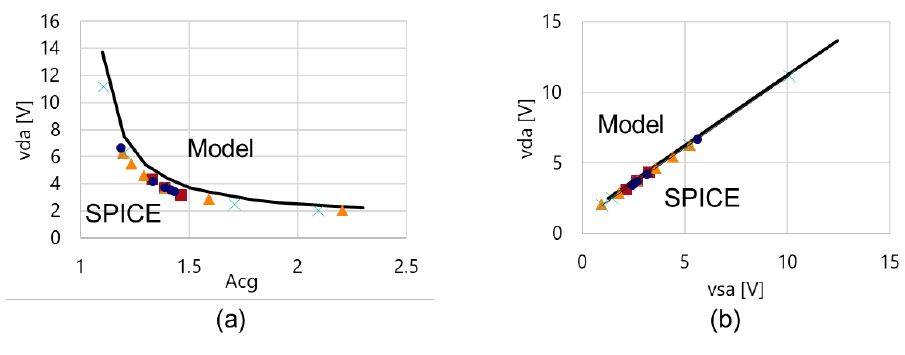
Figure 11. ( a ) A CG vs. vda and ( b ) vsa vs. vda .